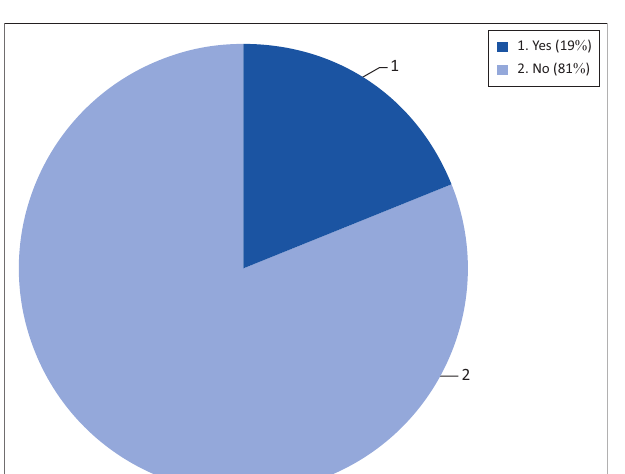
FIGURE 5: Frequency of user tagging.